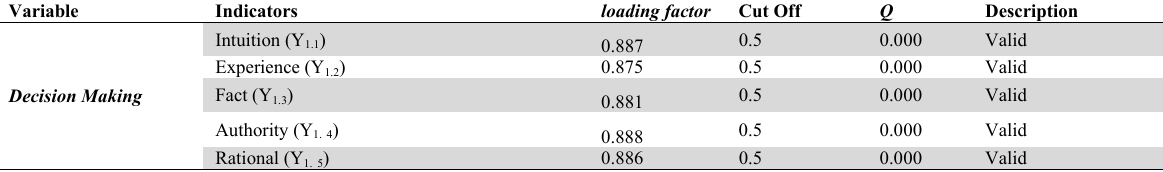
Coefficient Value of Loading Factor for Construct Decision